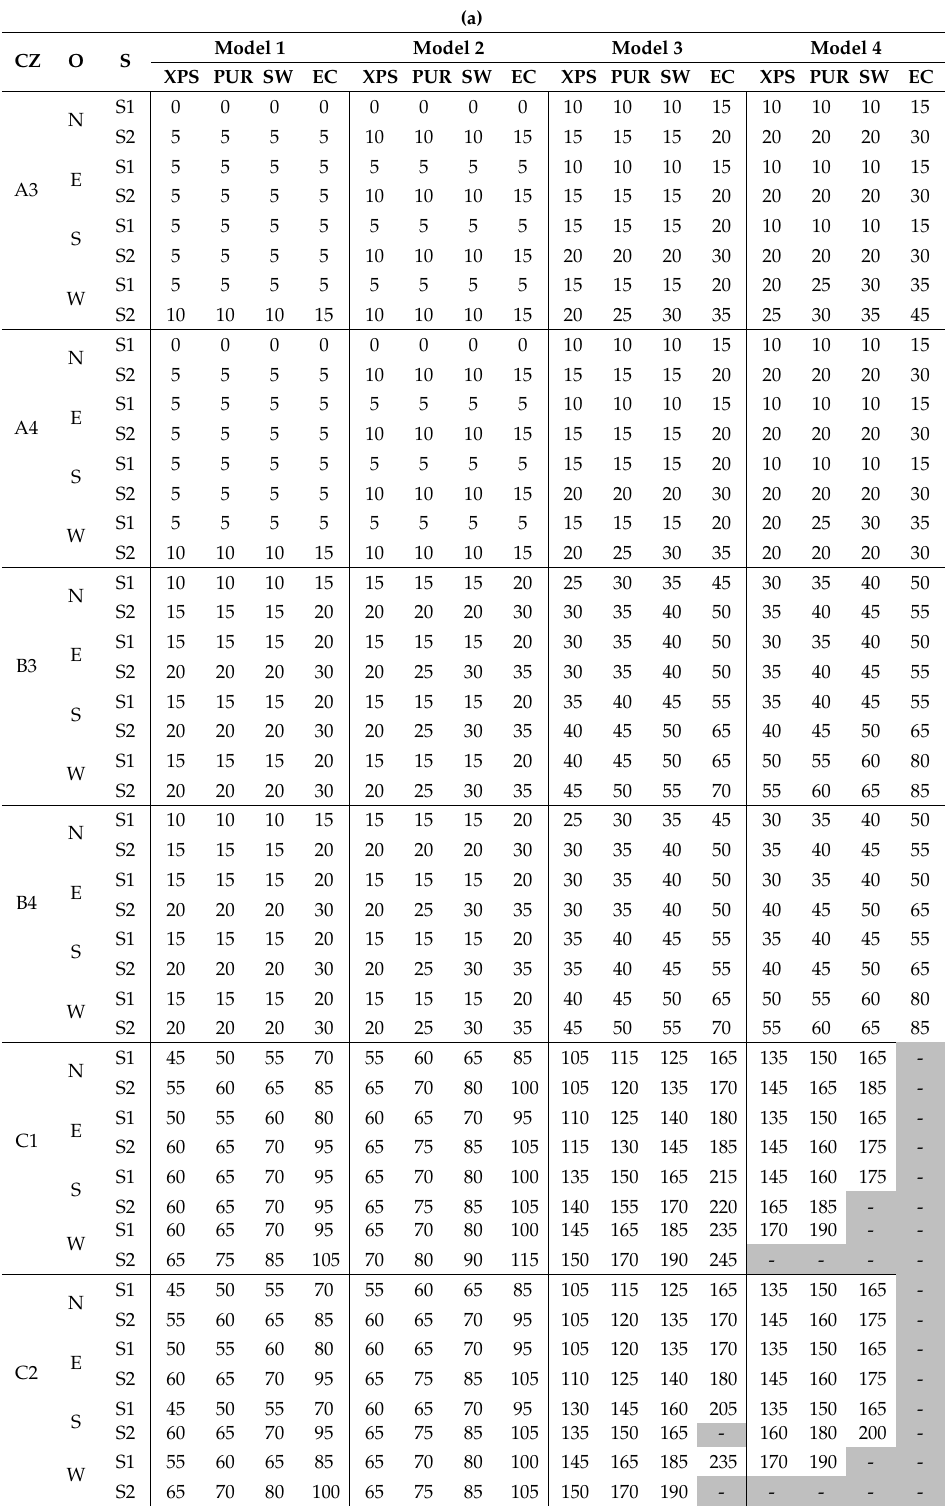
Table A3. Insulation thicknesses (in mm), for Hypothesis 3: Both heating and cooling demand ≤